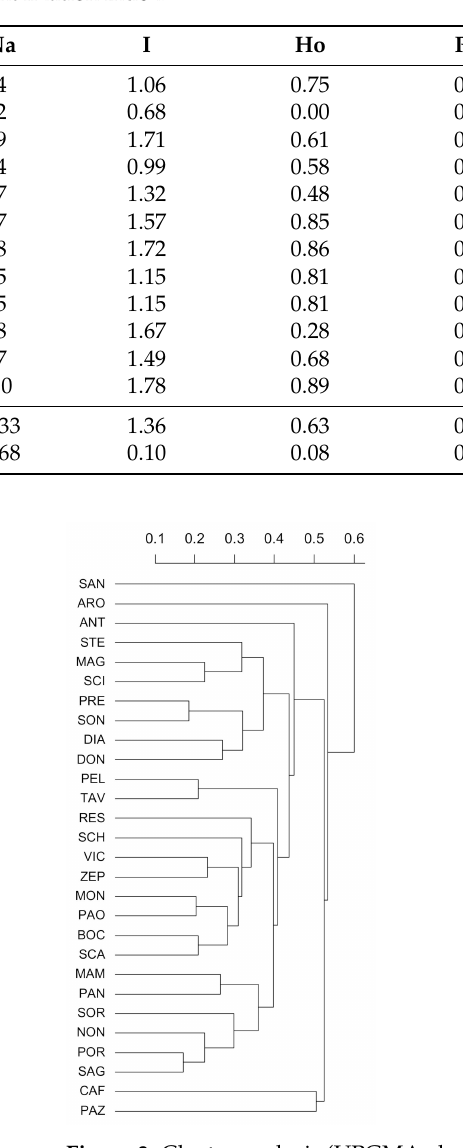
Figure 3. Cluster analysis (UPGMA algorithm based on Bruvo’s distances from SSR data) of the 28 apricot landraces. The scale bar for the genetic distance is presented on the top. To better visualize the differences between morphological and molecular data in describing diversity, we compared dendrograms. The correlation between the distances obtained with the two datasets (r = 0.18; p > 0.05; Mantel test with 9999 permutations) and the cophenetic correlation between the dendrograms (r = 0.19) were not significant. The tanglegram indicated that the resemblance depicted with the morphological traits did not largely correlate with that obtained with SSR markers (Figure